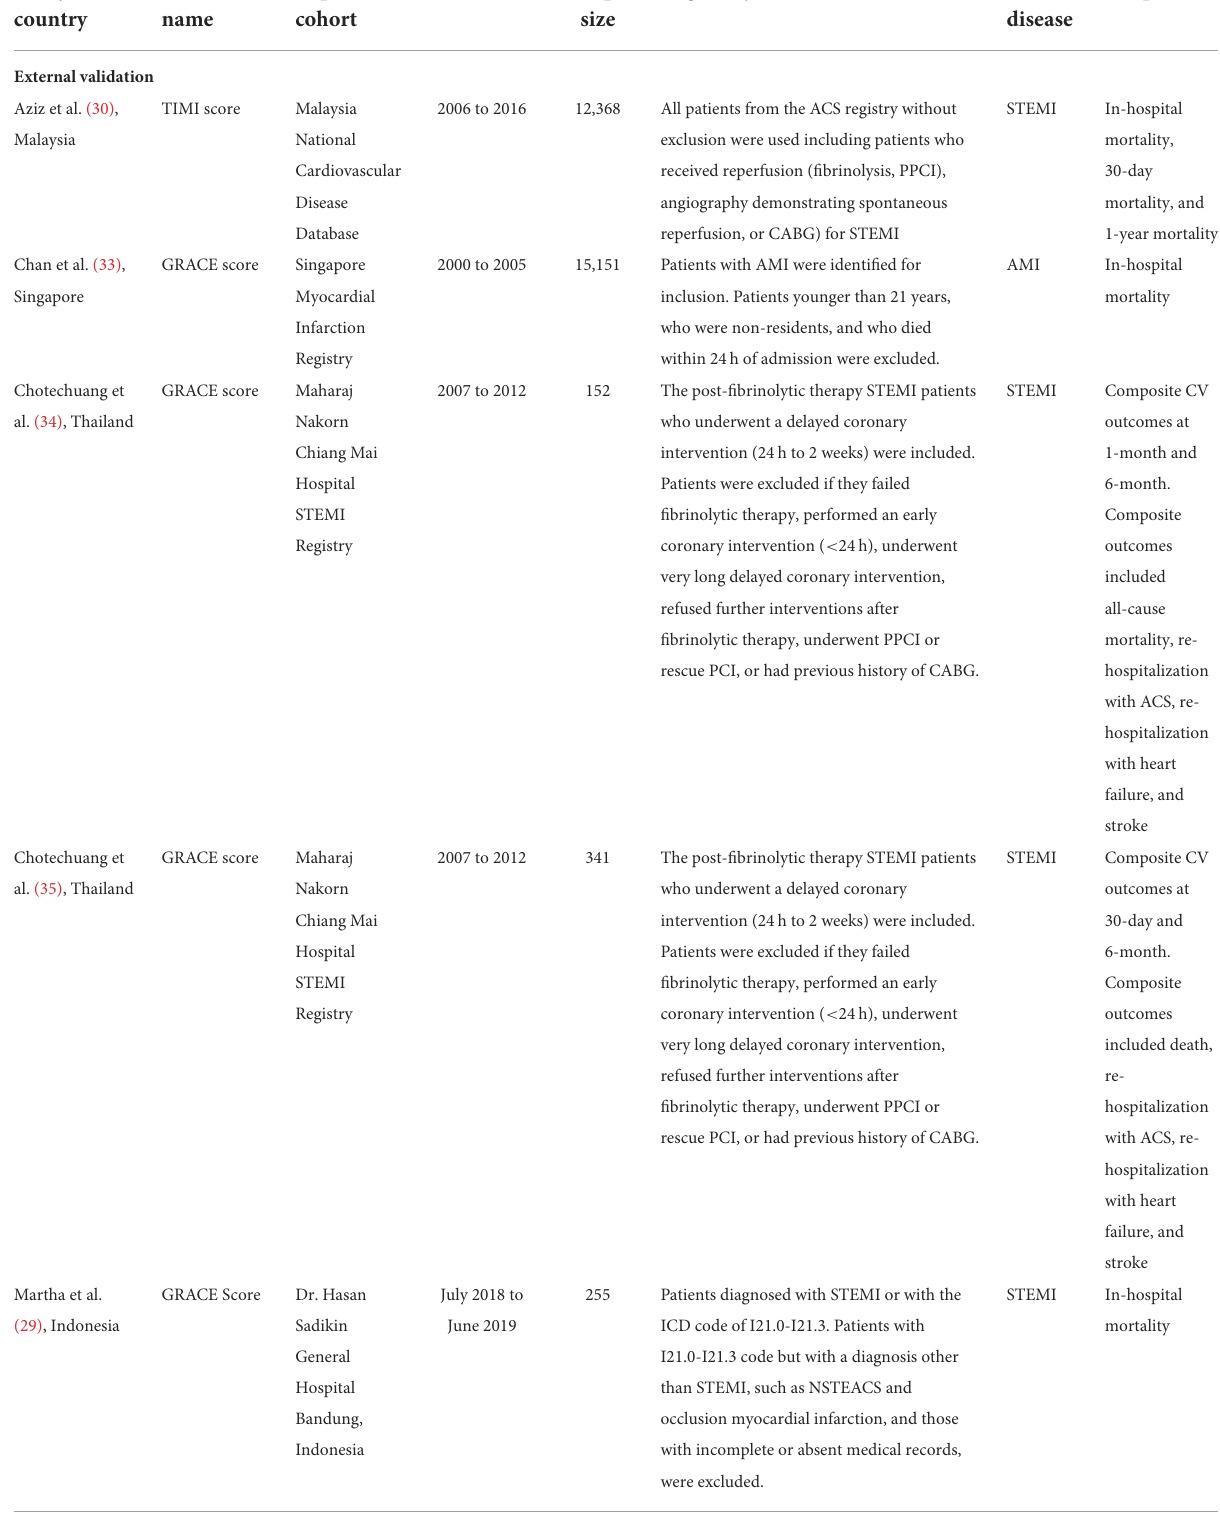
TABLE 1 Overall characteristics of the included